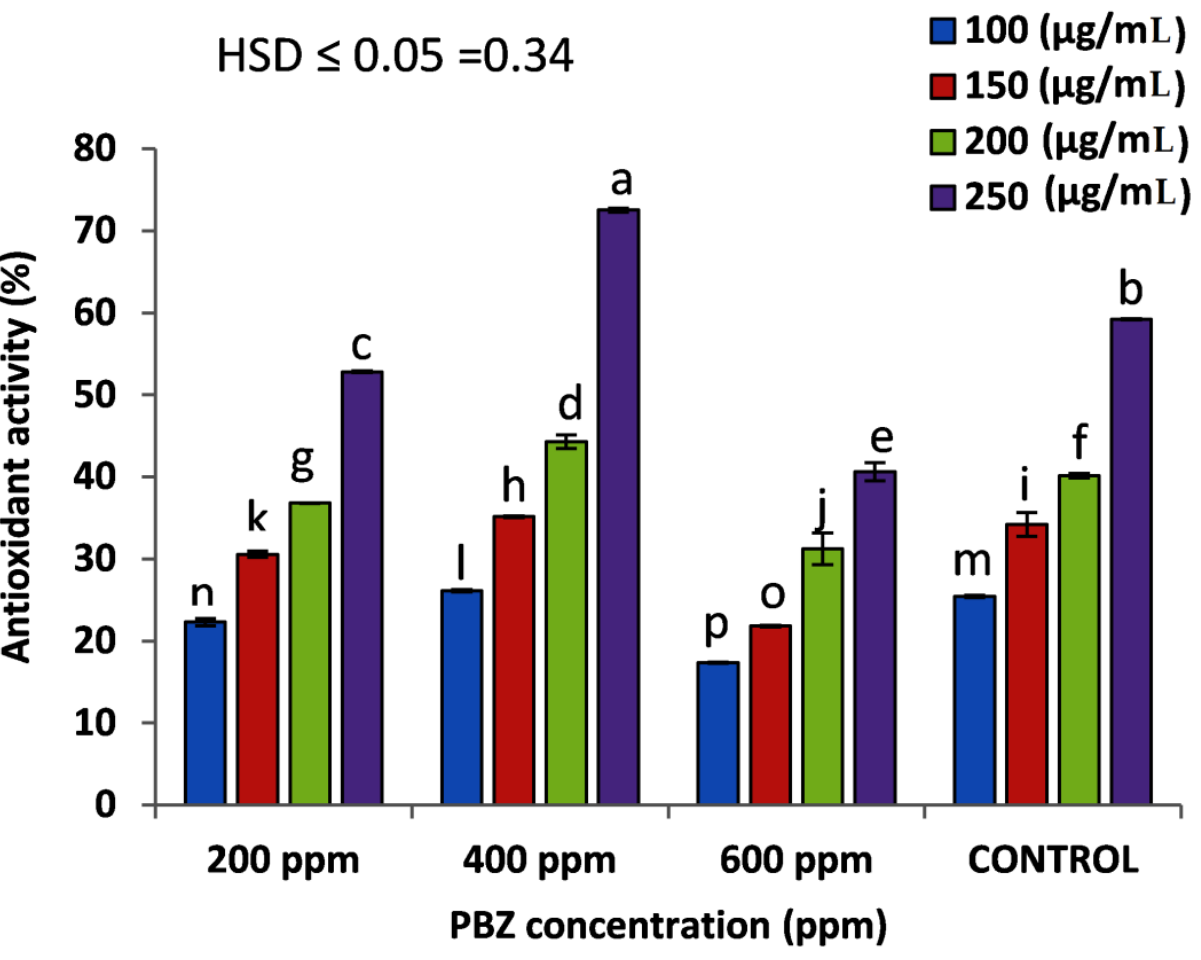
Figure 5. DPPH scavenging activity of different concentrations (100, 150, 200, and 250 µg/mL) of the essential oil extracted from lavender ( Lavender officinalis ) plants, treated and untreated with paclobutrazole; PBZ. Values are the averages of 3 replicates ± SD. Different letters indicate signifi- cant differences, according to Tukey ’ s Studentized Range (HSD) Test ( p < 0.05).